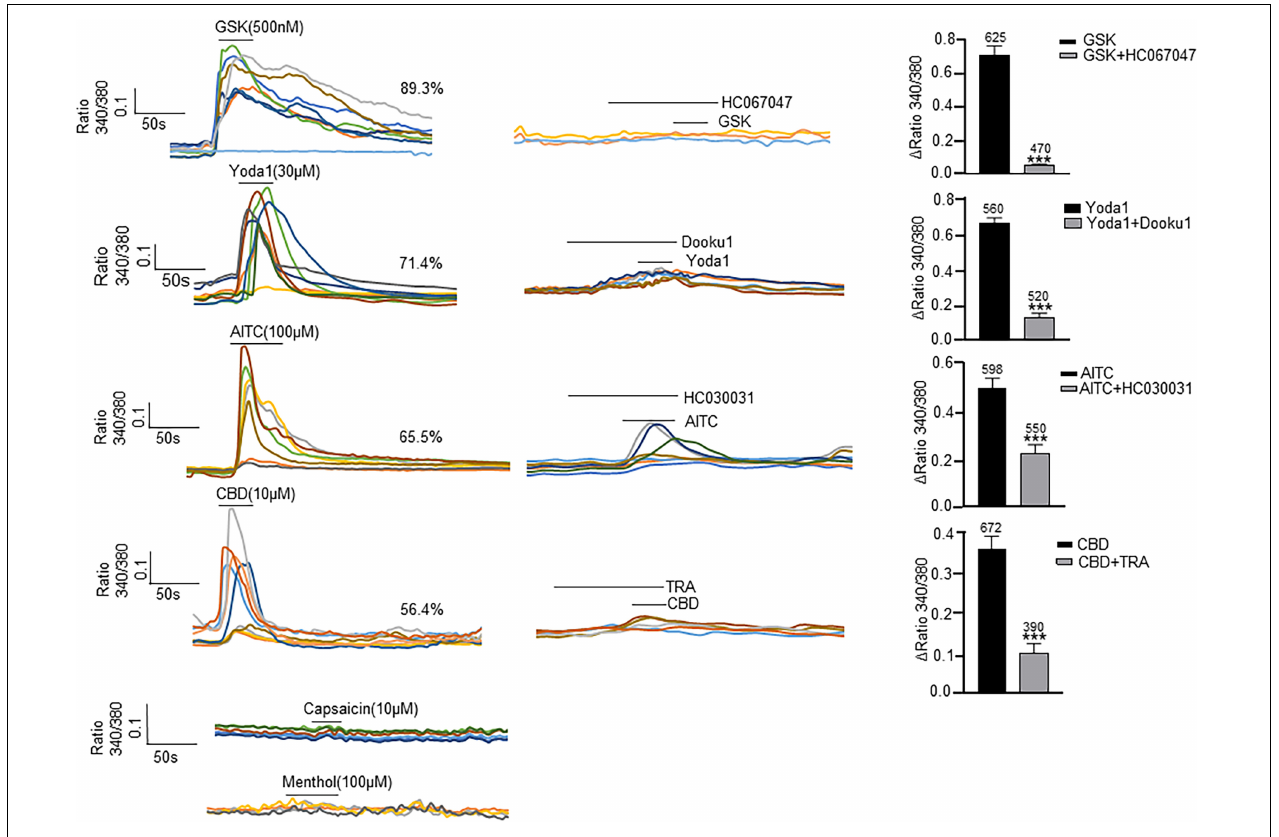
FIGURE 4 | Agonists specific for TRP and Piezo1 channels elicit an [Ca 2 + ] i increase in cultured LP-ICs. Left columns are typical traces showing application of the TRPV4 agonist GSK1016790A (GSK, 500 nM), Piezo1 agonist Yoda 1 (30 µ M), TRPA1 agonist AITC (100 µ M) and TRPV2 agonist cannabidiol (CBD, 10 µ M) to elicit a remarkable increase in [Ca 2 + ] i , respectively. The TRPV1 agonist capsaicin (10 µ M) and TRPM8 agonist methanol (100 µ M) did not evoke a significant increase in [Ca 2 + ] i . Agonists were applied for 30 s to 50 s. Middle columns are typical traces demonstrating that an increase in [Ca 2 + ] i induced by agonists of TRPV4, Piezo1, TRPA1 and TRPV2 was blocked by pretreatment with the corresponding antagonist. To avoid desensitization impacts, antagonists were applied in different coverslips with agonist experiments. Right columns are summary data for the blocking effects of antagonists. The number above each bar indicates the cell number. *** P <